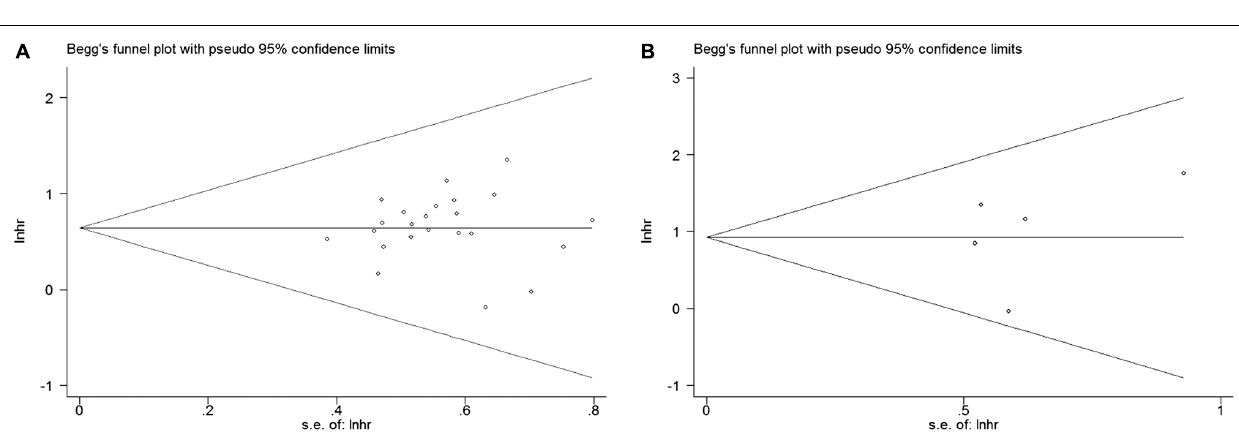
Frontiers in Physiology |